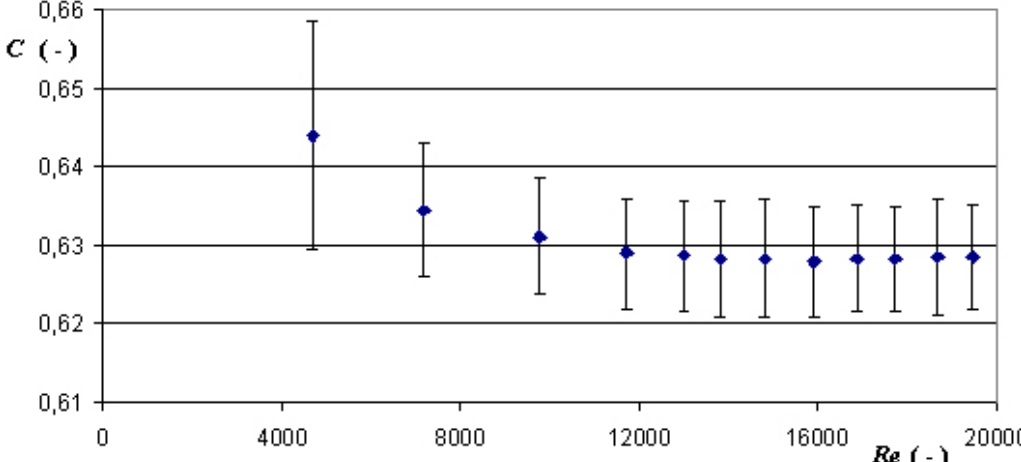
Figure 5. Value of discharge coefficient C depending on Reynolds number Re.